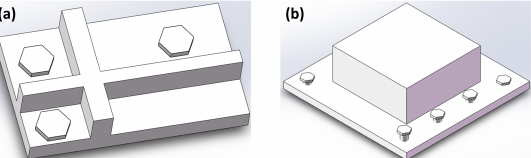
Figure 8. Examples of a complex disassembly environment. ( a ) Obstacles between target screws. ( b ) Target screws with different loose